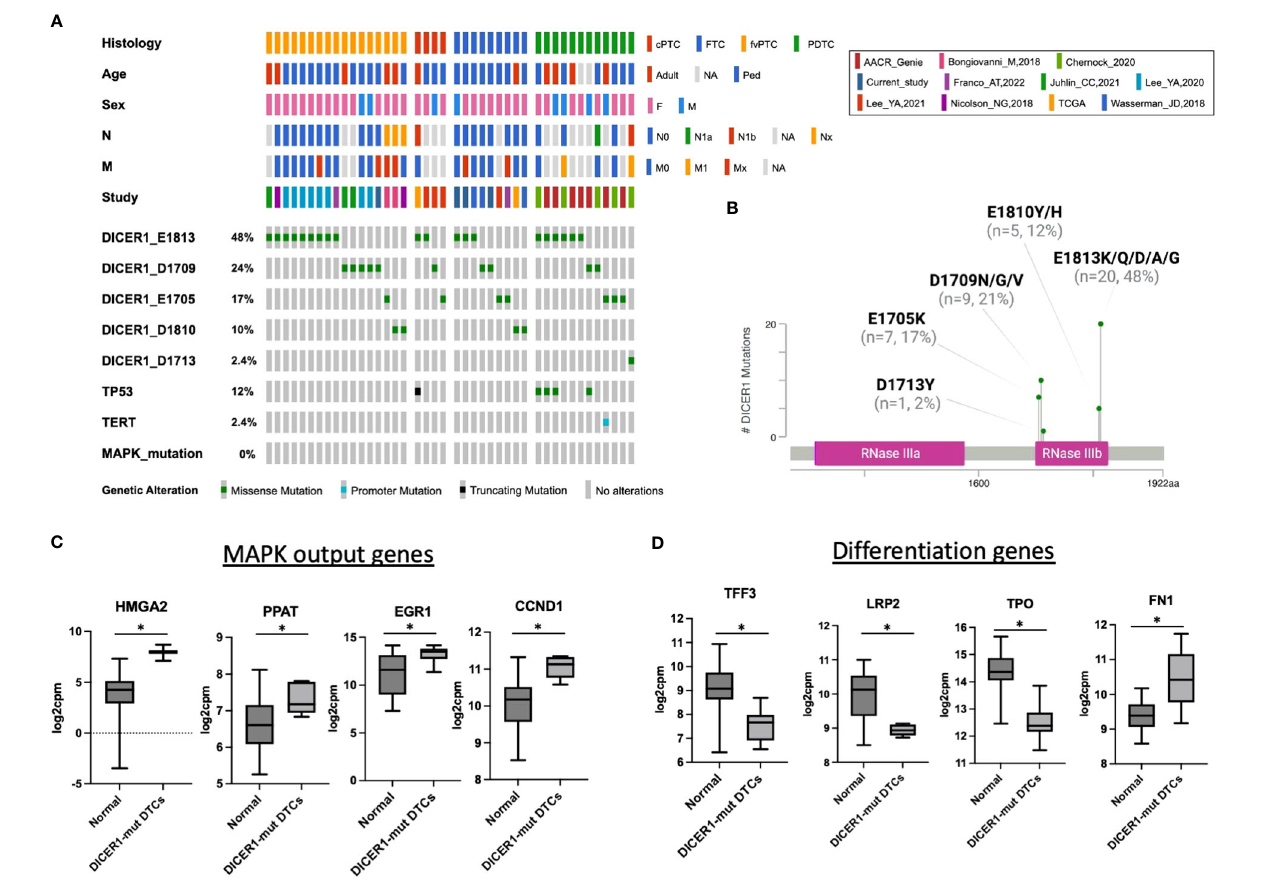
FIGURE 3 DICER1 RNase IIIb mutations are associated with increased MAPK output and loss of differentiation. (A) Oncoprint plot displaying 42 cases of DICER1 - mut thyroid cancers including the cases from current study and a review of the literature. Only mutations in the RNase IIIb domain and from malignant tumors were included. Clinicopathologic characteristics include age, sex, histology, N status and M status. The different studies included in the design of this plot are shown. DICER1 RNase IIIb mutations were categorized according to mutated codon. cPTC, classic papillary thyroid cancer; FTC, follicular thyroid cancer; fvPTC, follicular variant papillary thyroid cancer; PDTC, poorly differentiated thyroid cancer; N, lymph node metastasis status; M, distant metastasis status. (B) DICER1 mutation lollipop plot depicting RNase IIIb mutations from 42 patients with thyroid cancer. (C) Expression of selected MAPK output genes present in the HTG Oncology Biomarker Panel in non-neoplastic/hyperplastic vs DICER1 -mutant cases. (D) Expression of genes related to thyroid differentiation in non-neoplastic/hyperplastic vs DICER1 -mutant cases. Asterisk represent p <